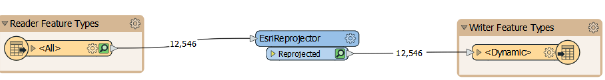
Figure 3. Data reprojection of vectors and 3D models